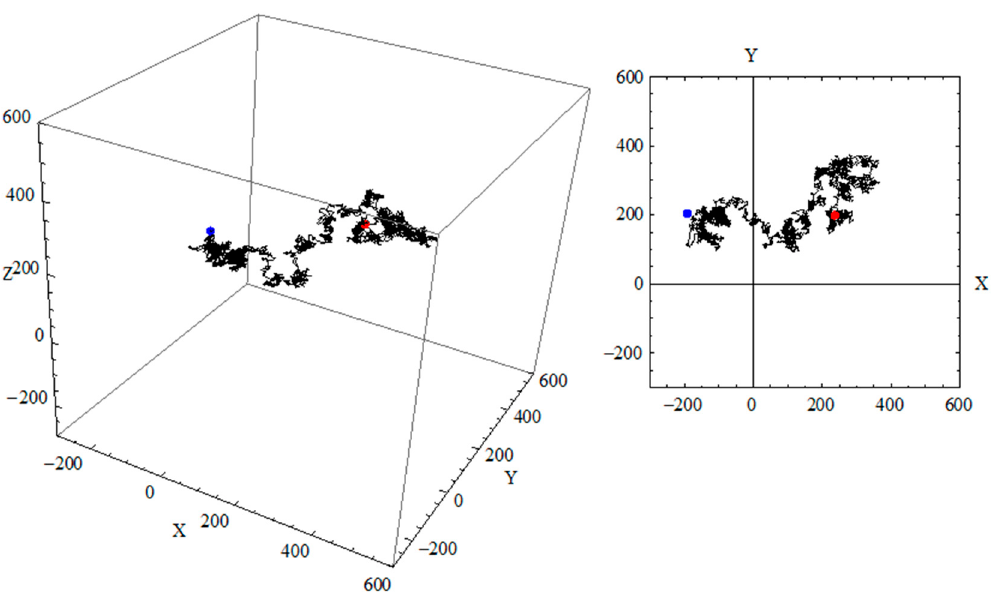
Figure 5. Sample trajectory of a walker in a digitized pore network of deteriorated cement paste including the projected trajectory in three orthogonal planes.